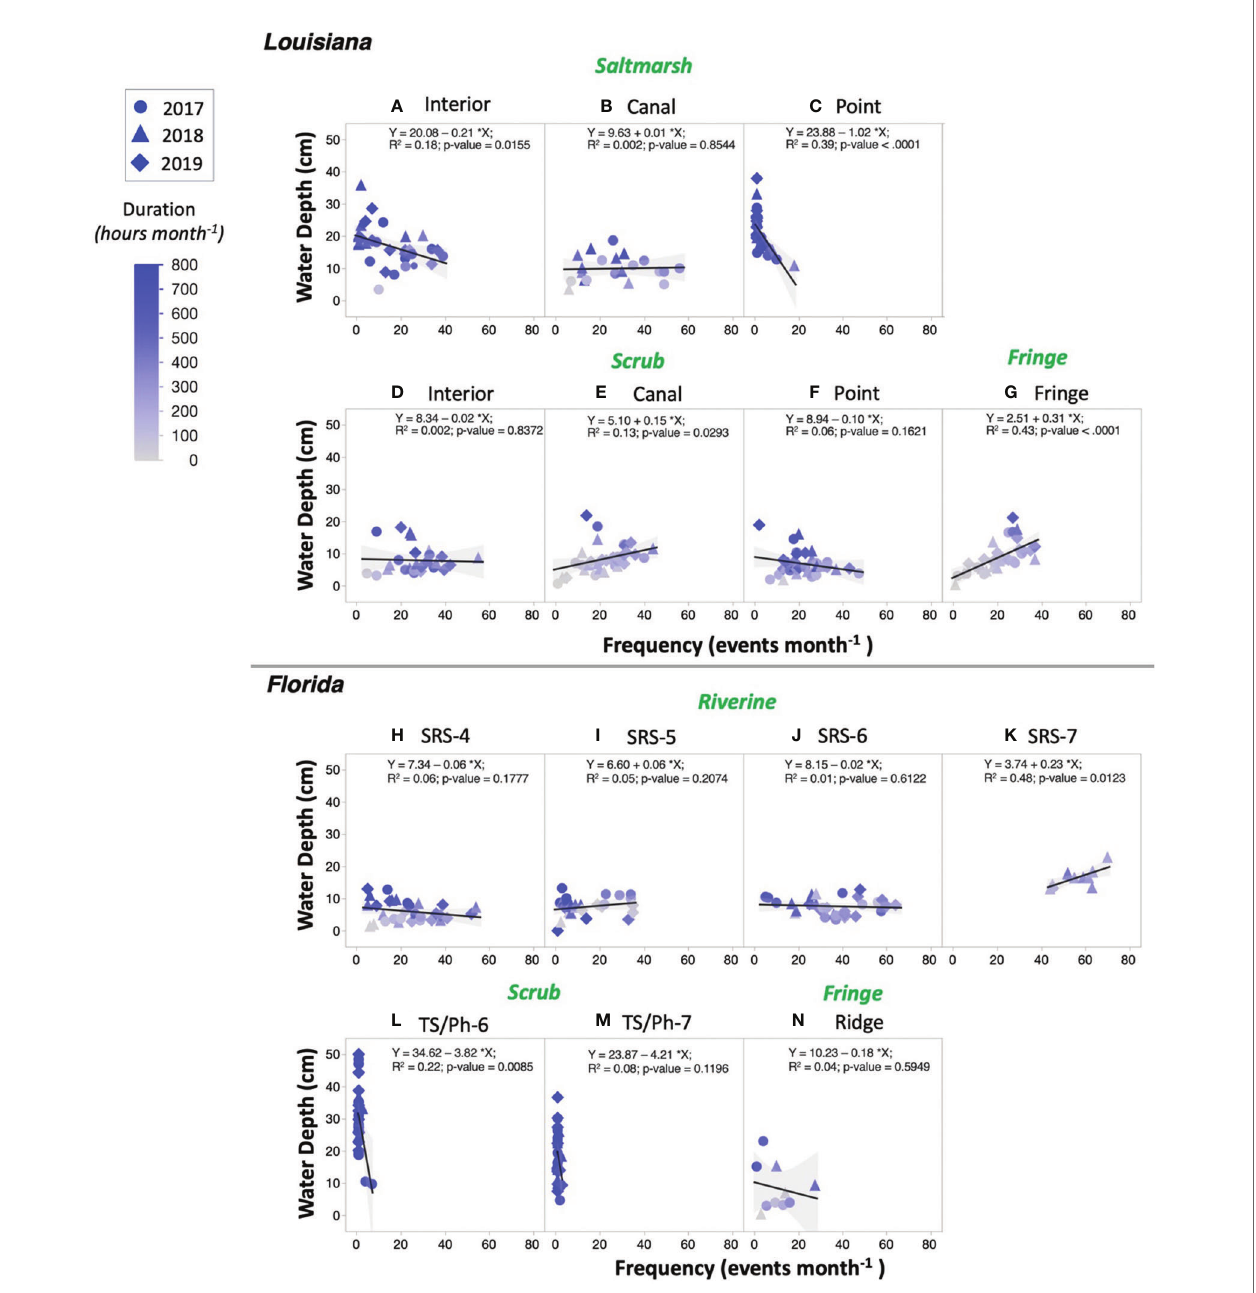
FIGURE 6 | Monthly hydroperiod gradients across vegetation types and sites summarized based on in situ water levels collected in wetlands from year 2017 to 2019. Linear regressions were performed between monthly frequency of inundation (count of fl ooding events in a month; events month -1 ) and fl ooding water depth (average of positive water level when the wetlands are fl ooded; cm). The gradient blue color represents the monthly duration of inundation (total fl ooding hours in a month; hours month -1 ). The gray shade indicates the 95% con fi dence